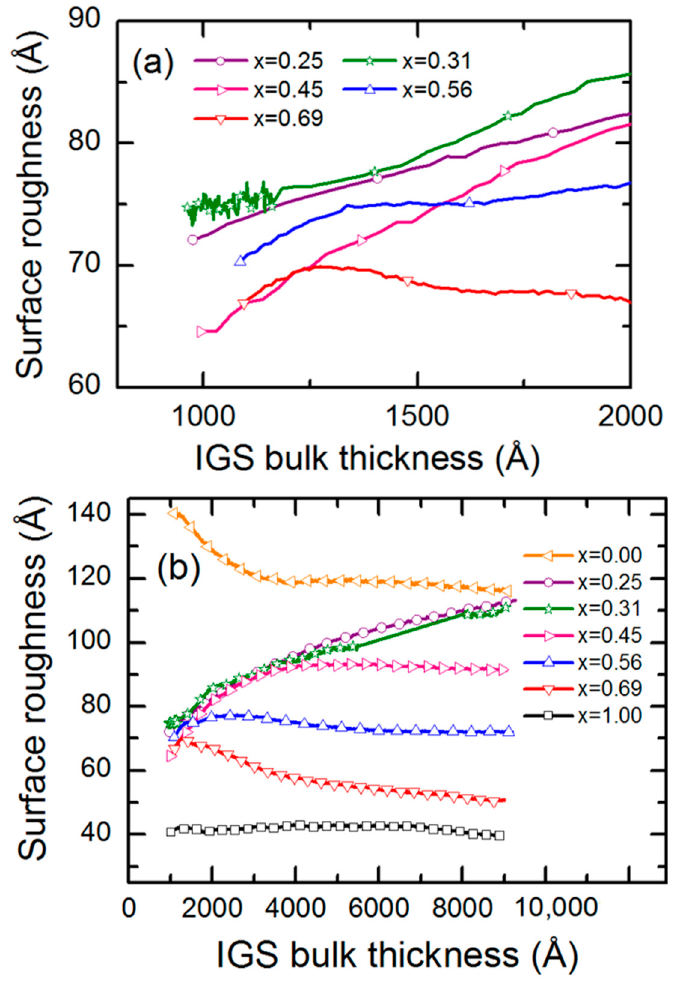
Figure 16. ( a ) Evolution of the surface roughness thickness for IGS films of selected composition x = [Ga]/{[In] + [Ga]} over the bulk layer thickness range of 1000–2000 Å; ( b ) extension of the results of ( a ) to a larger sample set and covering a wider range of bulk layer thickness. In both parts the ( ε 1 , ε 2 ) spectra used in the analysis were obtained from multi-time analysis at a center time within the range of 3500–4100 Å.